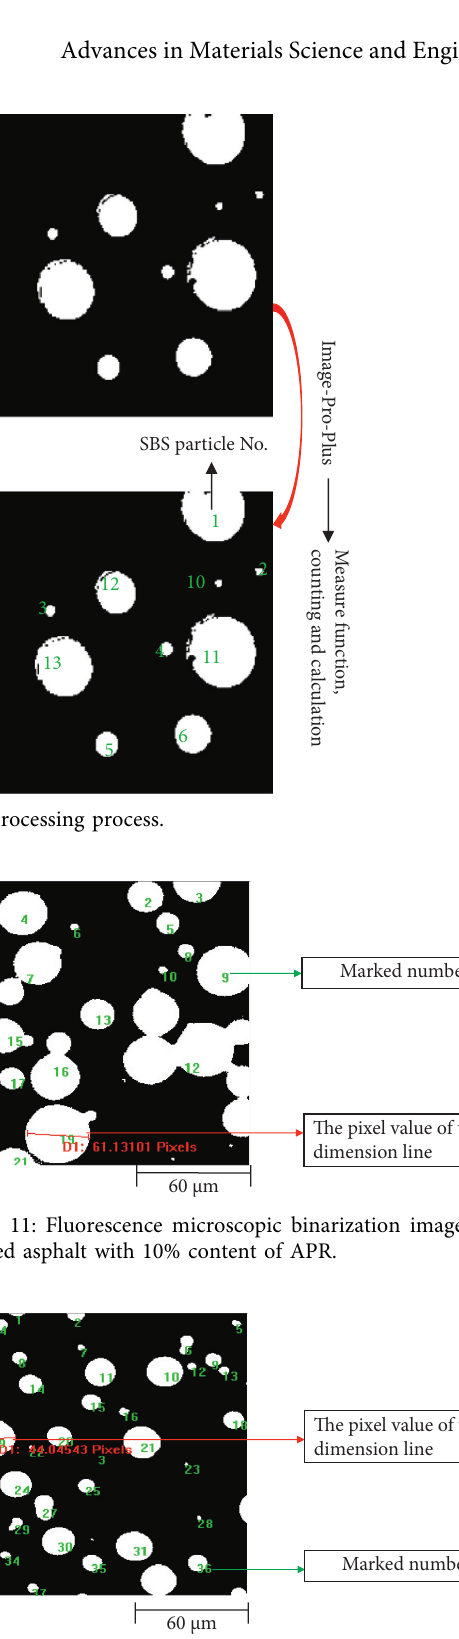
Figure 12: Fluorescence microscopic binarization image of SBS modified asphalt with 15% content of